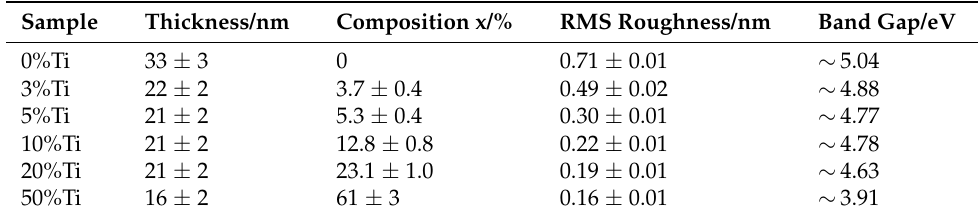
Table 1. Summary of film characteristics. Samples are named after the percentage of Ti ALD cycles used for growth. Film thicknesses, obtained by ellipsometry, are estimates, since an appropriate fitting represents the amount of Ti relative to Ga in the films. RMS roughness and band gaps were determined by AFM and UV-vis transmittance spectroscopy,